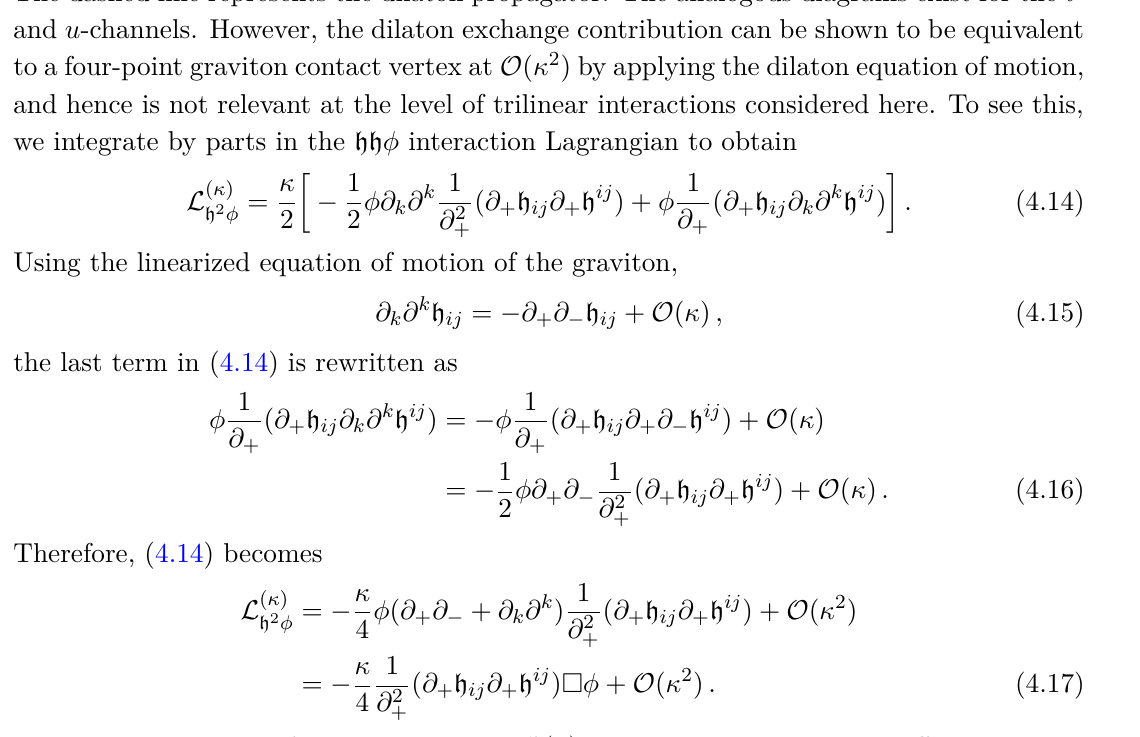
2 graviton scattering in !